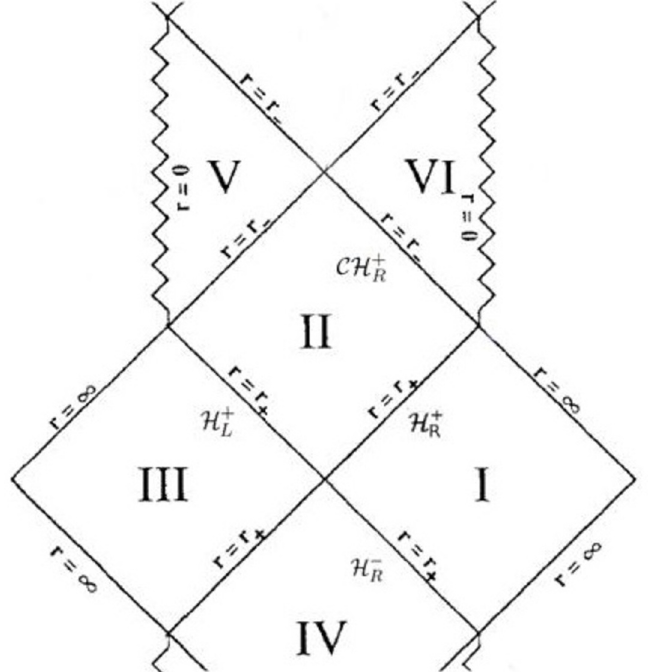
Figure 1 . Penrose diagram of the 3-dimensional black string: (We ignore the region of r < 0 . See [37].) Note that a proper Penrose diagram of the black string cannot be drawn on a flat surface like this